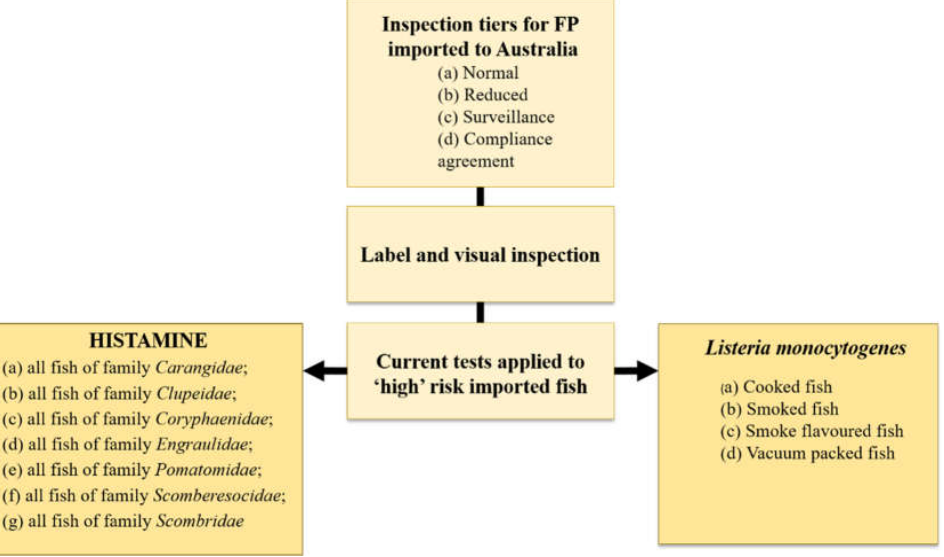
Figure 1. The current tests applied to high risk imported fish on entry to Australia. Listeria monocytogenes at present is the only additional test for bacteria applied to imported fish on entry to Australia. Original figure based on information in the Imported Food Control Order, 2020.